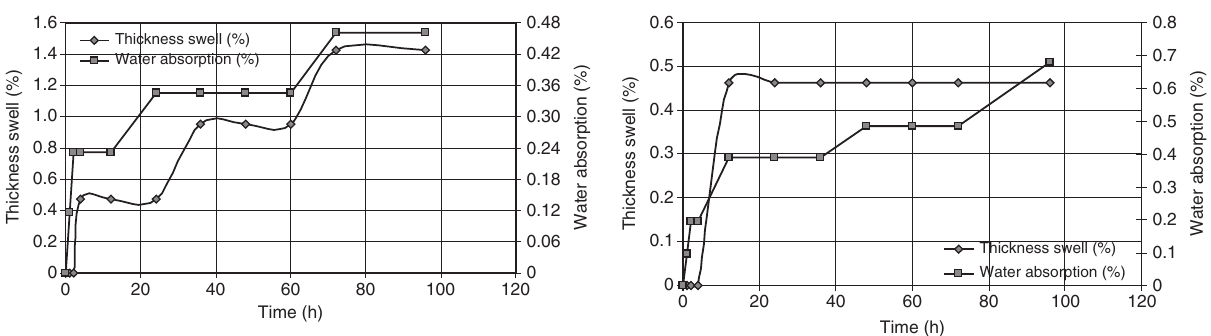
Figure 14 WA and TS for 10 wt% almond shell-based biocomposite in RW.